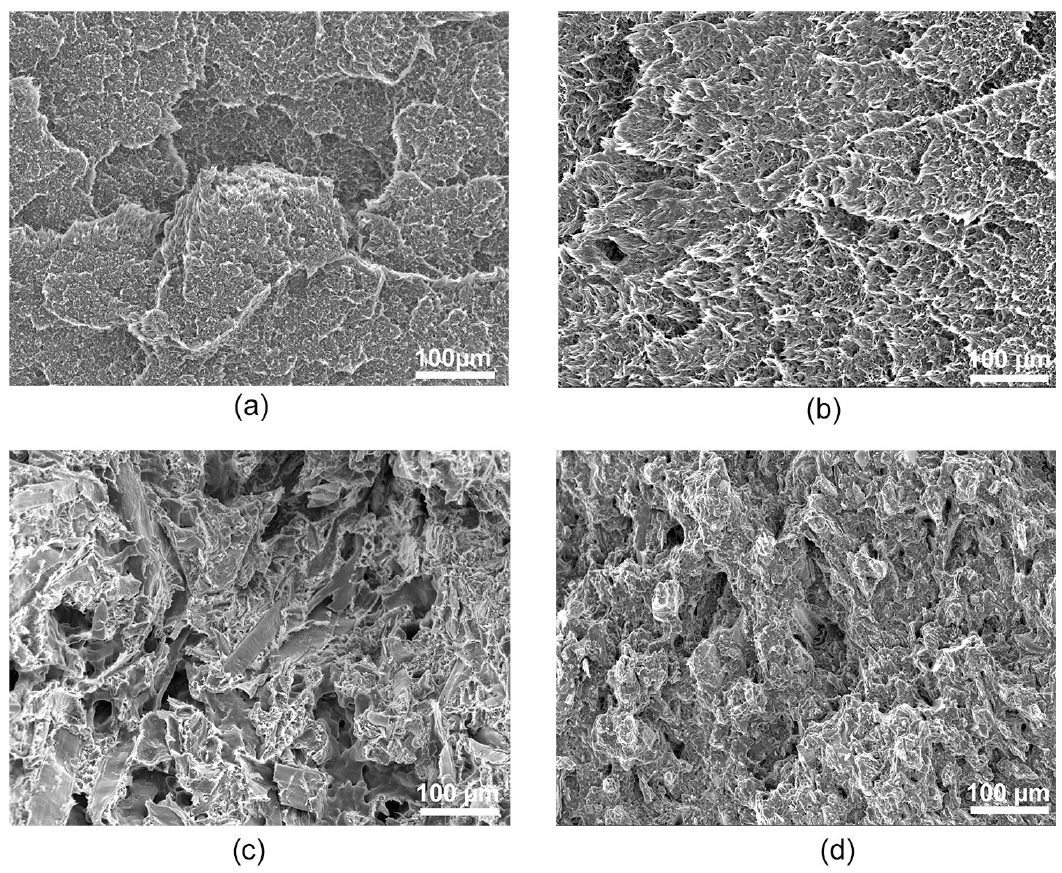
Figure 12. SEM images of fracture surfaces ( a ) PP-0, ( b ) PP-9, ( c ) WPC-0, and ( d ) WPC-9 (scale bar: 100 µm).